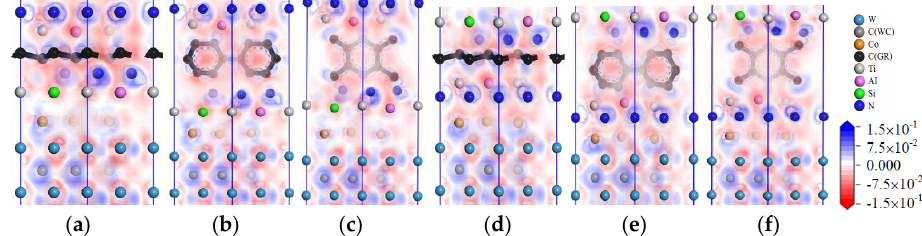
cases, the doping of defective graphene weakens the bonding force between atoms at the interface.